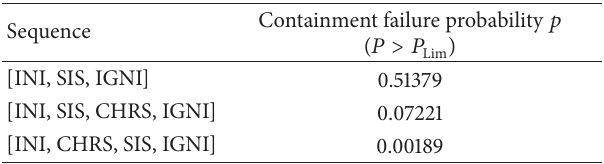
Table 2: Containment failure